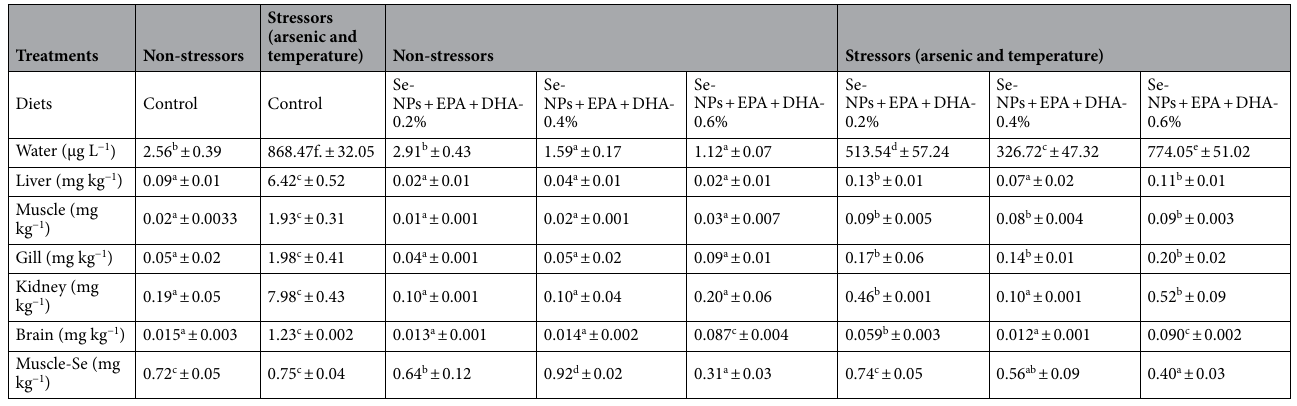
Table 8. Mitigation of tertiary stress response (residue accumulation of arsenic) through dietary supplementation of selenium nanoparticles, eicosapentanoic acid and dicosahexanoic acid fed to P. hypophthalmus reared in control or under arsenic and high temperature for 105 days. Values in the same row with different superscript (a, b, c, d, e) differ significantly p < 0.05; Data expressed as Mean ± SE (n = 3).